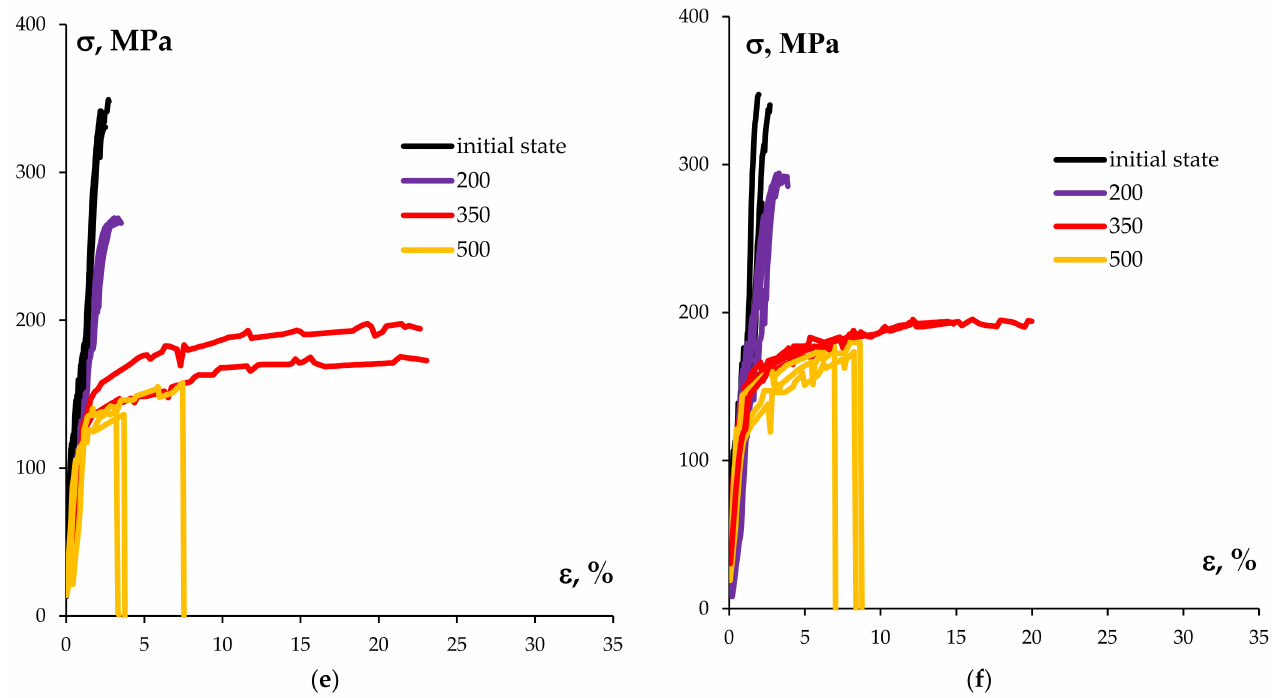
Figure 9. The tension curves σ ( ε ) of the sample wires made from alloys #1 ( a ), #2 ( b ), #3 ( c ), #4 ( d ), #5 ( e ), and #6 ( f